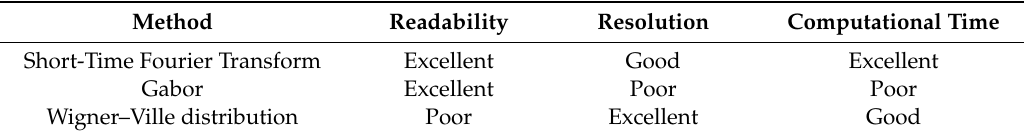
Figure 6. The result of Time-frequency spectrogram: ( a ) Short-Time Fourier Transform (STFT), ( b ) Gabor, and ( c ) Wigner–Ville distribution (WVD). Table 1. Comparison of time-frequency estimator.